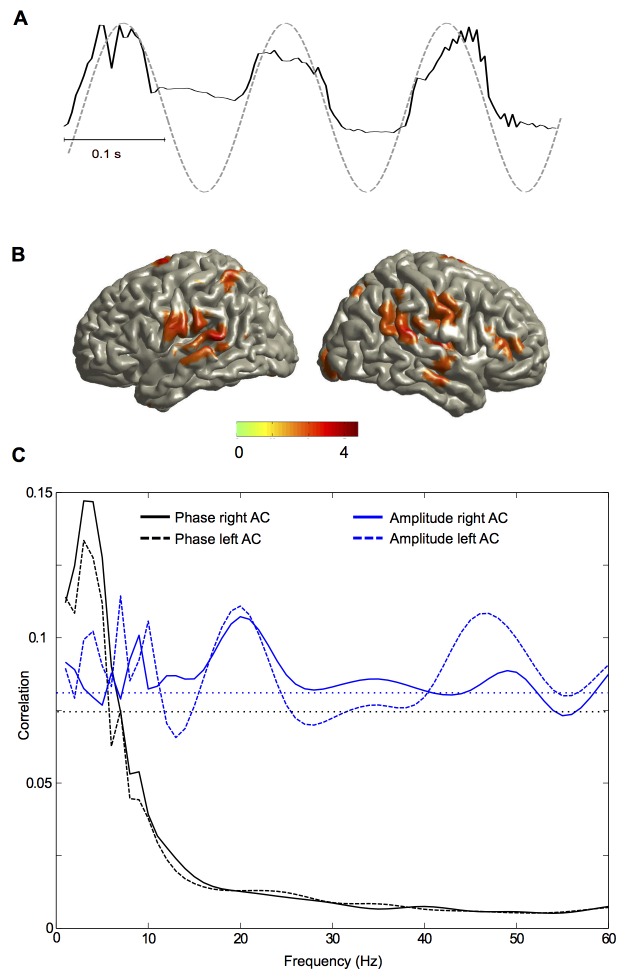
Oscillatory speech sampling.(A) Speech envelope (black line) and cosine of theta phase of the right auditory cortex of one participant for one trial. (B) The spatial distribution of significant correlation between low-frequency (3–7 Hz) phase and speech envelope (p<0.05, FDR corrected). The statistical map shows t-values of the statistical contrast between correlations for the story condition and trial-shuffled surrogate data. (C) Spectrum of cross-correlation between oscillations in the left and right auditory cortex and speech envelope. Black lines correspond to correlations based on the cosine of phase and blue lines to correlations based on amplitude. Solid lines represent the right auditory cortex and dashed lines represent the left auditory cortex. Horizontal dotted lines show 95th percentile of chance distribution of the maximum across frequencies obtained from shuffled data for phase (black) and amplitude (blue).